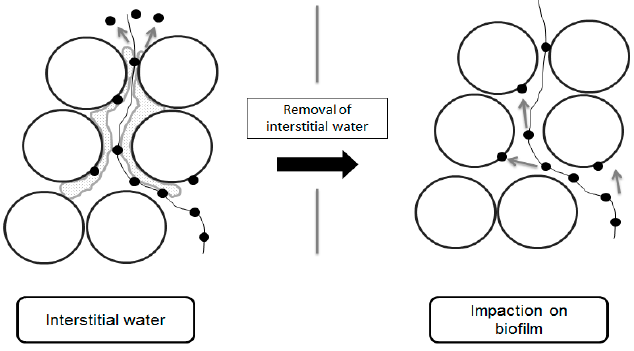
Figure 5. Explaining mechanism: disappearance of interstitial water and enhancement of the impaction phenomenon.